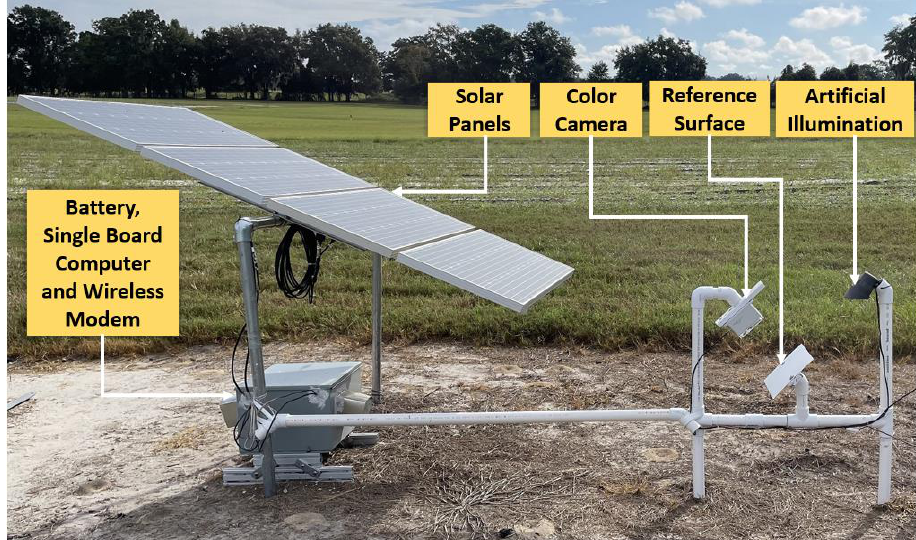
Figure 1. System to monitor a reference surface using an RGB camera at UF PSREU, Citra.